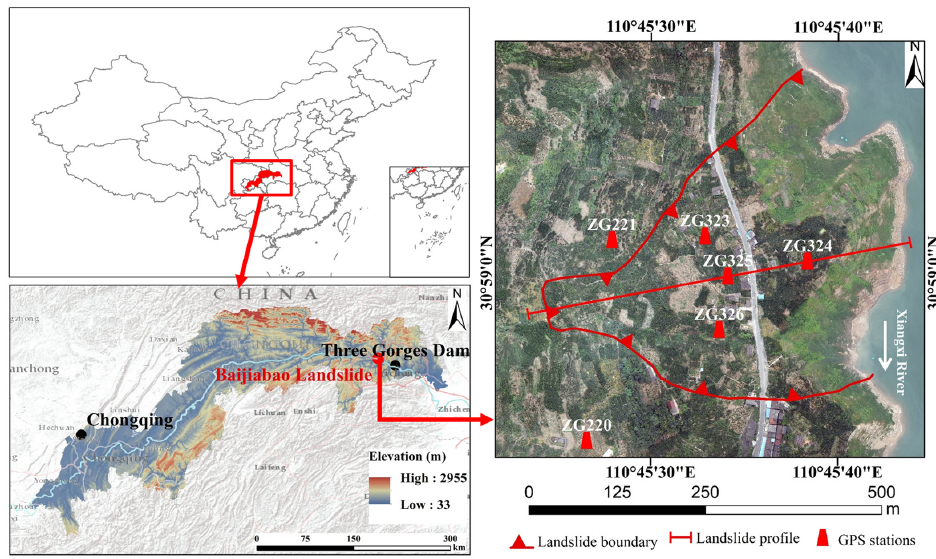
Figure 3. Location and GPS monitoring stations of the case study.